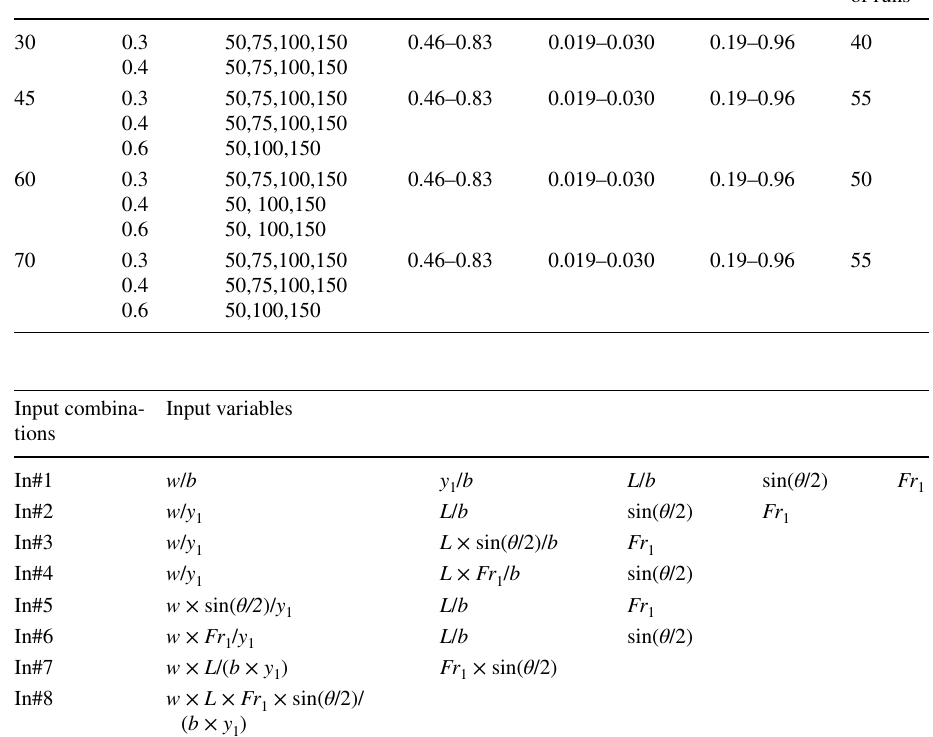
Table 1 Variations in the experimental parameters of the improved triangular side weir (Borghei and Parvaneh